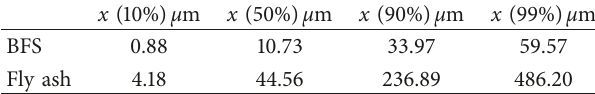
Table 1: Particle size distribution of raw materials.